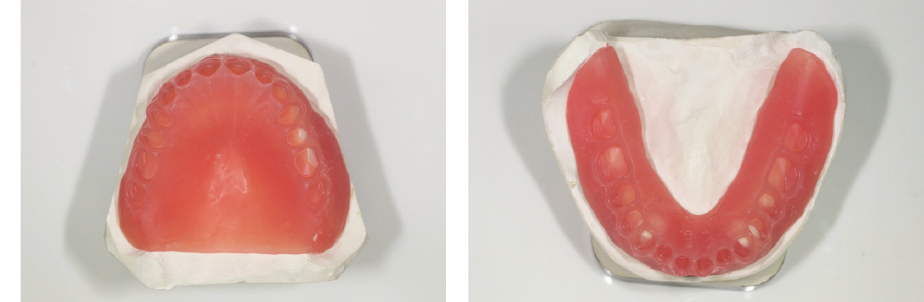
Figure 11: Denture bases.